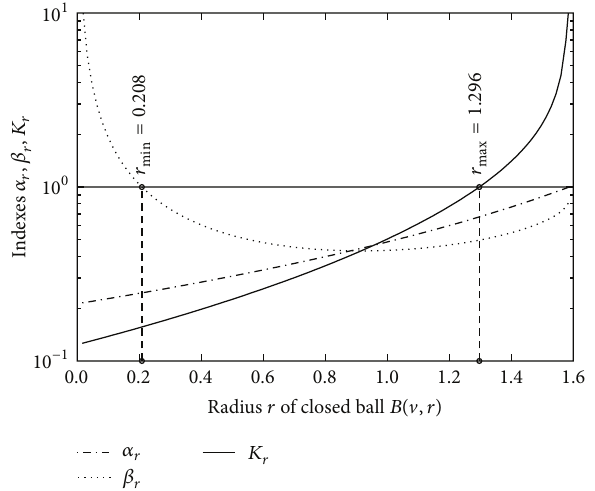
Figure 1: Test of global convergence for polynomial 𝑝(𝑥) = 𝑥 16 + 5𝑥 15 + 5𝑥 14 − 1